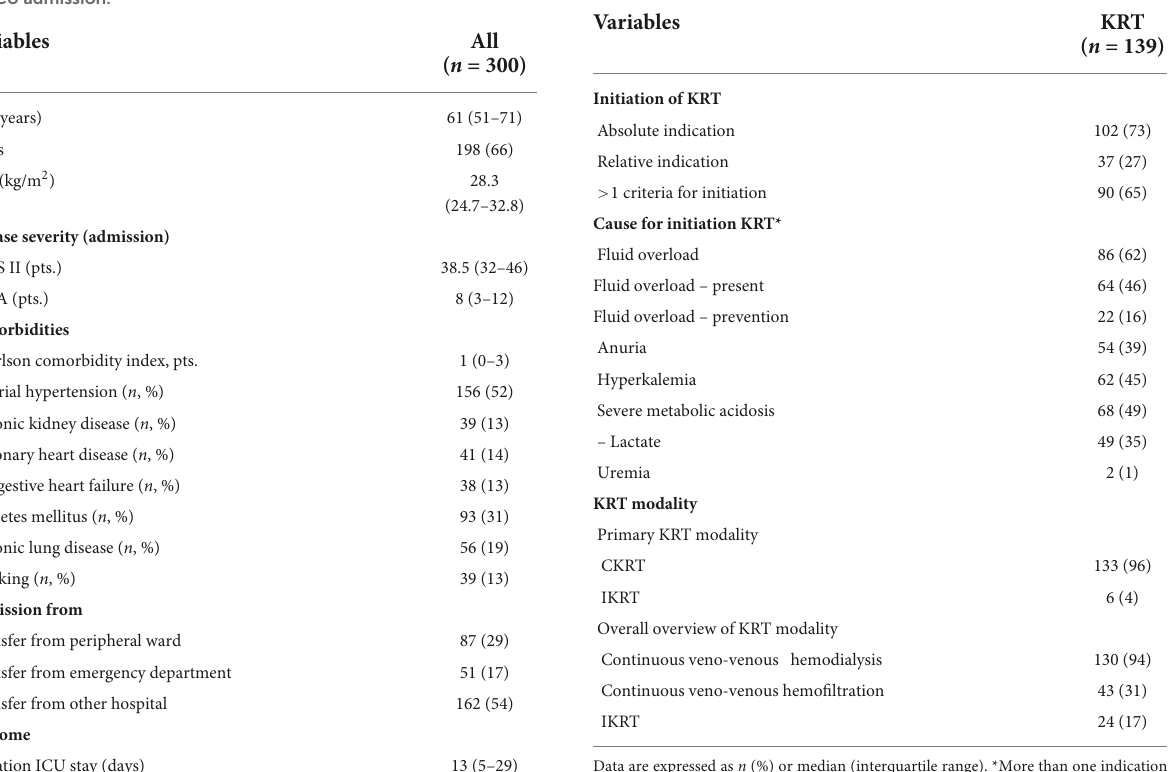
TABLE 2 Cause for KRT and modality of